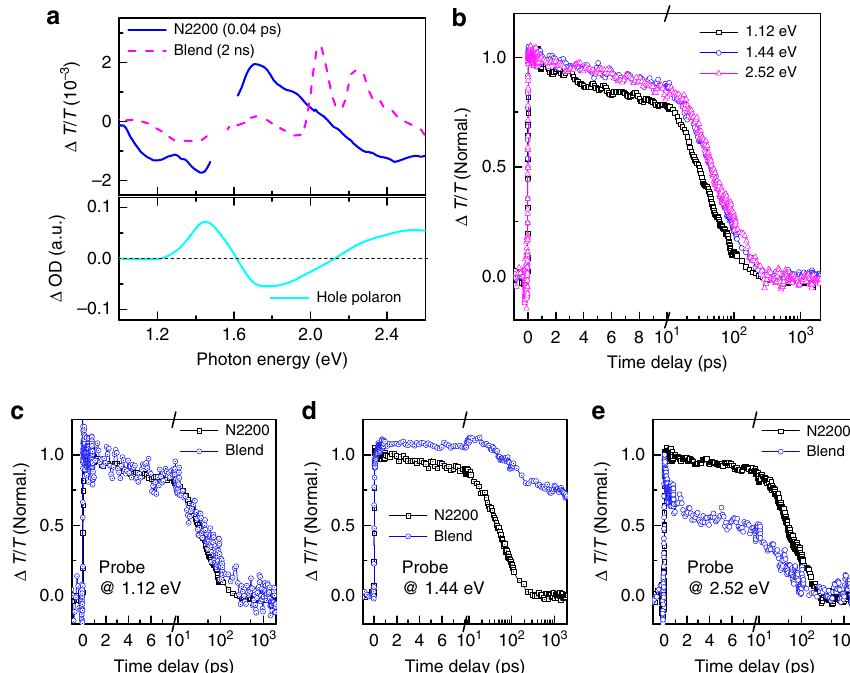
Fig. 3 Hole transfer mediated by iPPs. a A TA spectrum of a neat fi lm N2200 recorded at the time delay of 40 fs is shown in comparison with that of the blend fi lm recorded at 2 ns (upper). One GSB band around 1.75 eV and three ESA bands around 1.12 eV, 1.44 eV, and 2.52 eV are clearly identi fi ed. The excitation photon energy is 1.75 eV. The absorption change induced by positive charges in the polymer N2200 characterized by the spectro- electrochemistry measurements shows the absorption features of polarons at 1.44 and 2.5 eV (lower). b The decay dynamics of the three ESA bands in the neat N2200 fi lm. The decay dynamics of the neat N2200 and the blend fi lms probed at c 1.12 eV, d 1.44 eV, and e 2.52